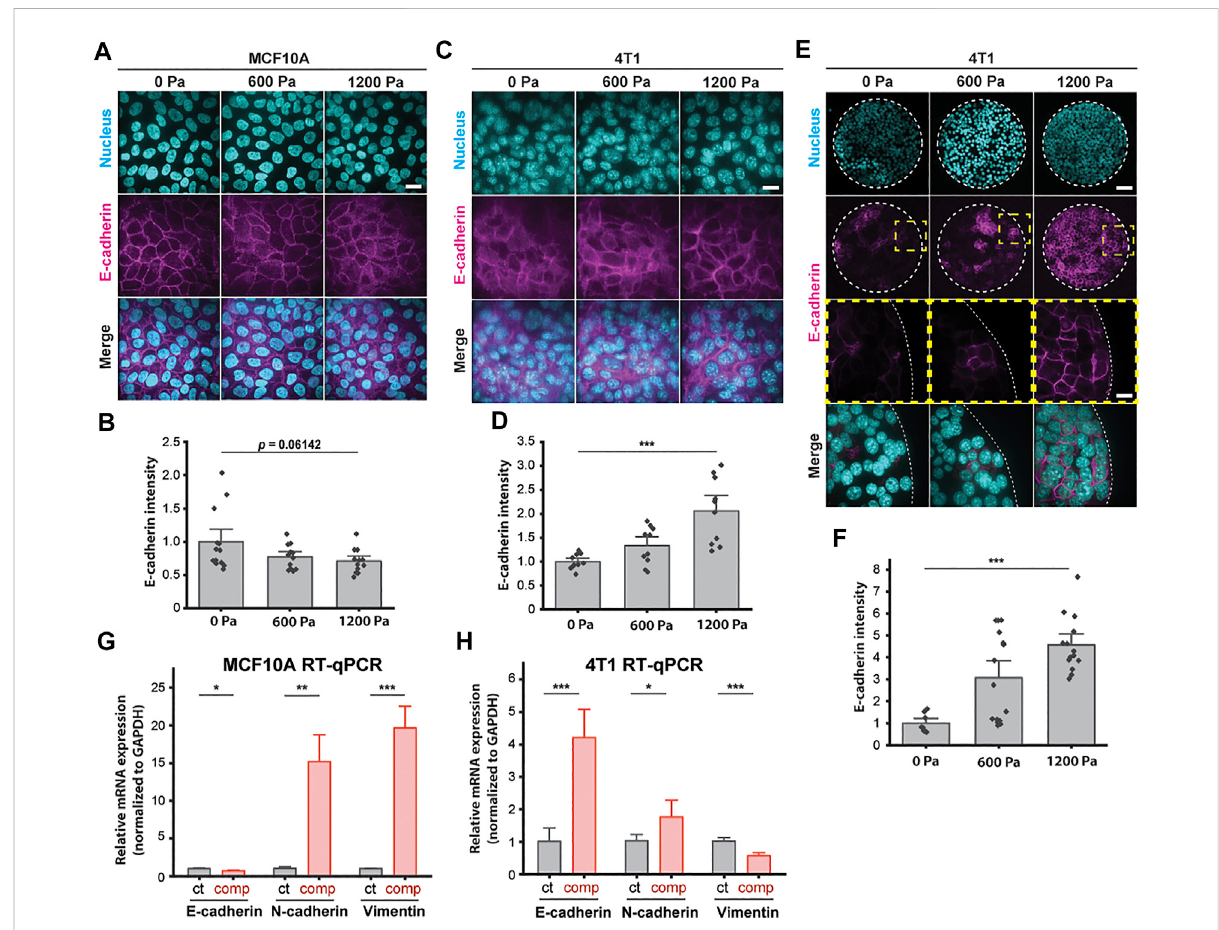
20 µm. (B) Quanti fi cationofrelativeE-cadherin fl uorescence atMCF10A cell – cellcontacts.Mean fl uorescenceintensity atthecell membrane ±S.E. is plotted from three independent replicates ( n = 12 – 13). (C) Representative microscopy images of 4T1 cells labeled with DAPI and